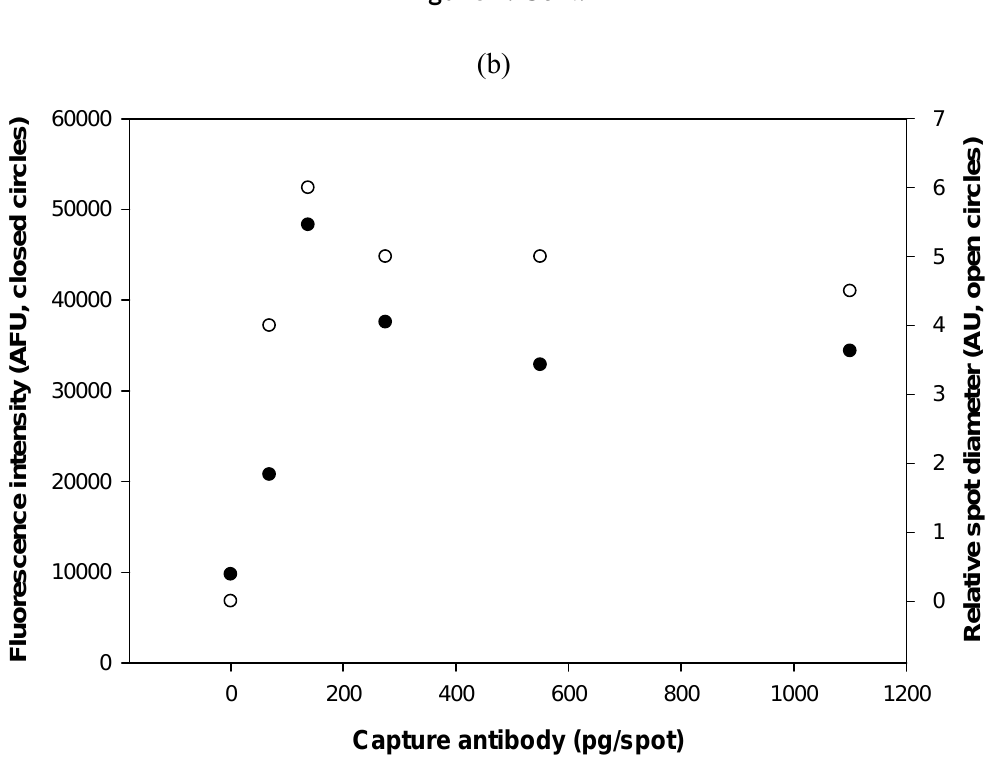
Capture antibody